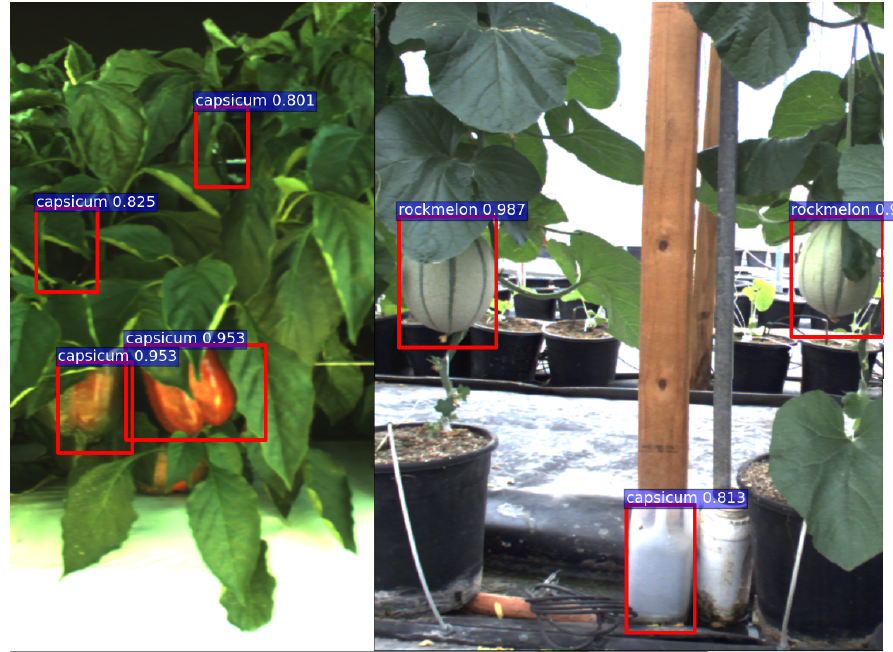
Figure 22. Detection result when two fruits are present in the scene. Two images are manually cropped, stitched and then fed to the RGB